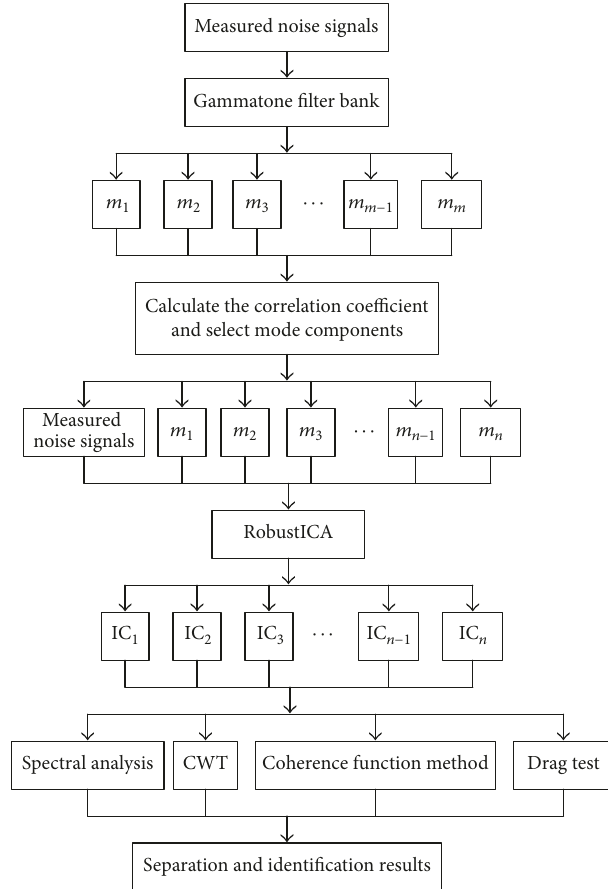
Figure 3: Calculation flow of the Gammatone-RobustICA